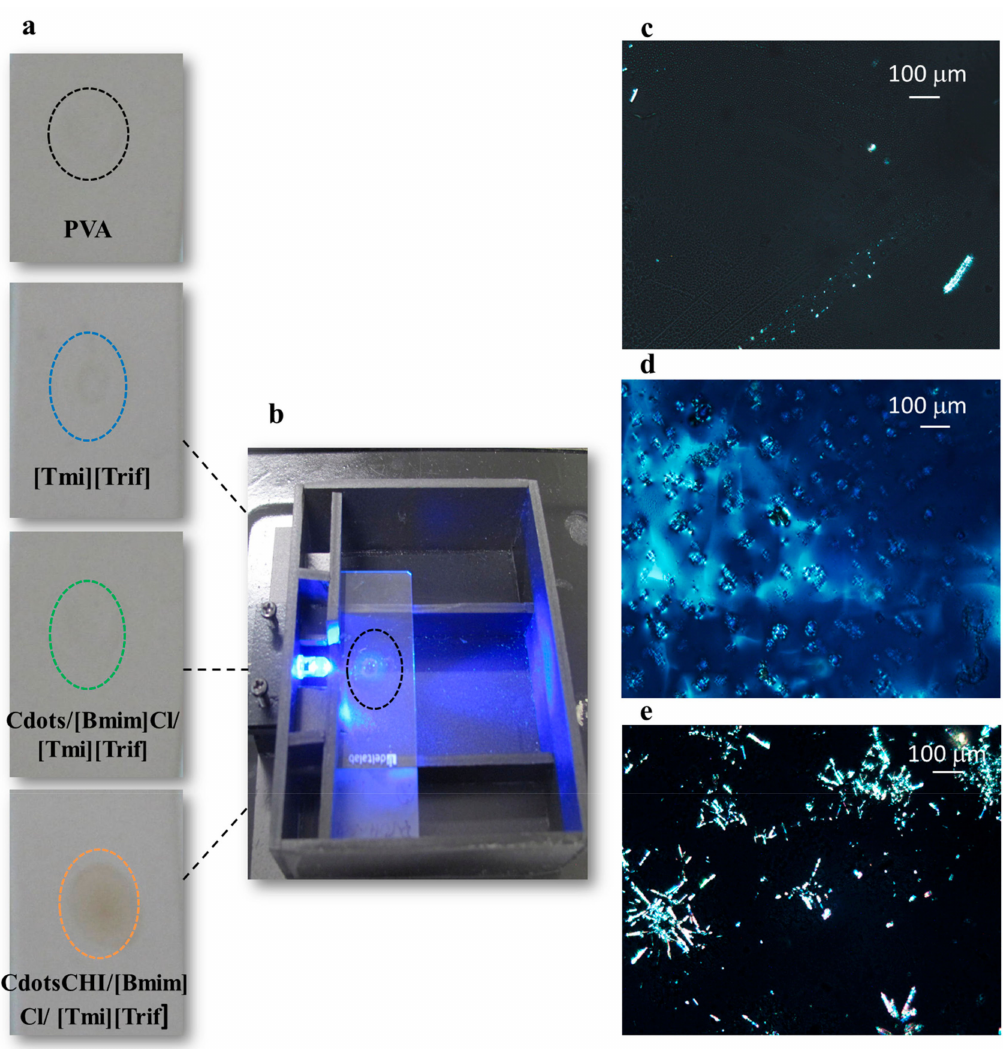
Figure 9. ( a ) Images of the PVA membranes. ( b ) Fluorescence image acquired on a homemade device for acquiring the fluorescence of solids using a 450 nm LED as an excitation